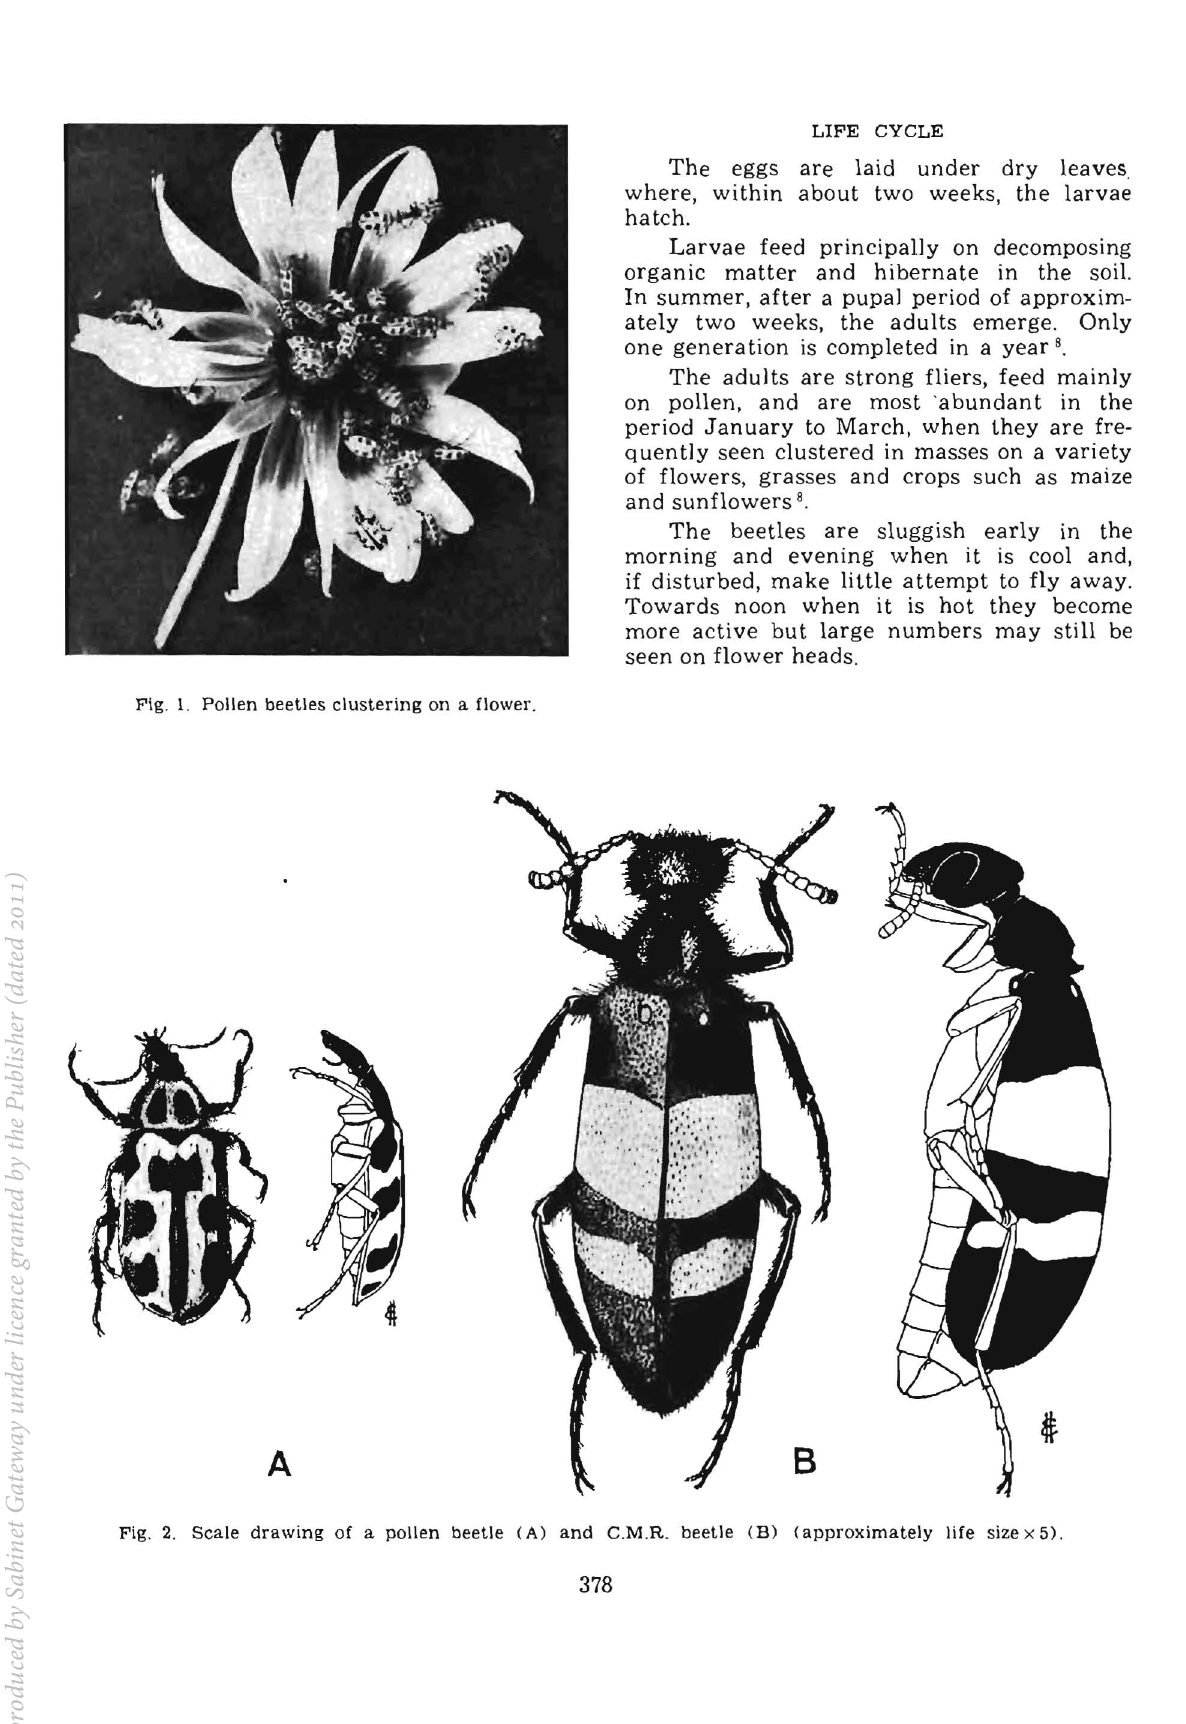
Fig. 2. Scale drawing of a pollen beetle (A) and C.M.R. beetle (B) (approximately life size x